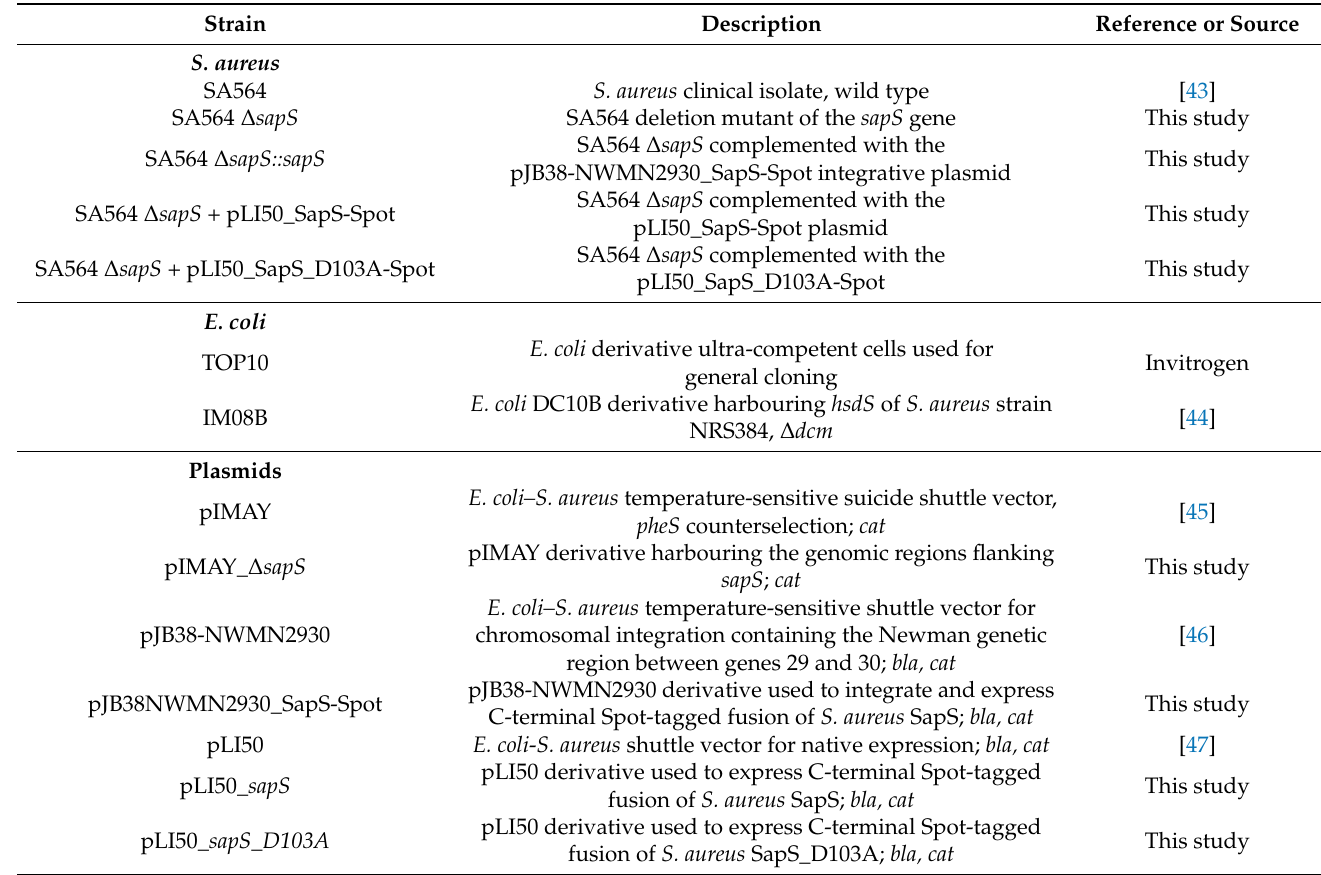
Table 1. Strains, plasmids, and primers used in this